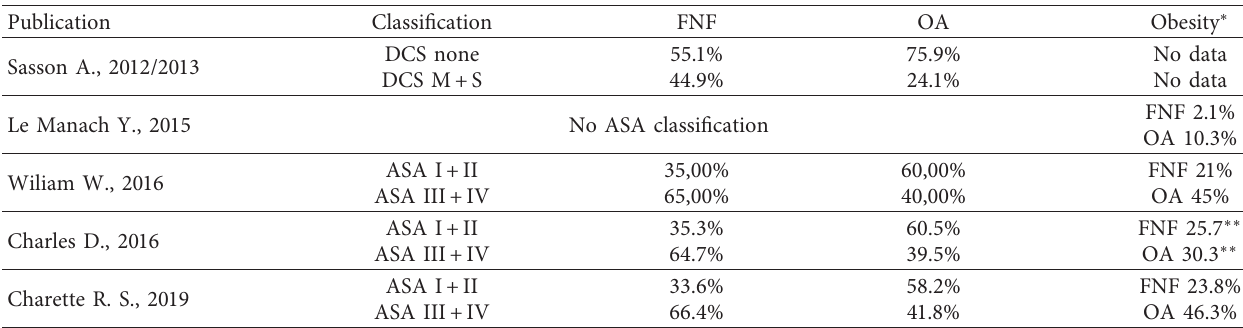
Table 3: Comorbidities’ comparison.